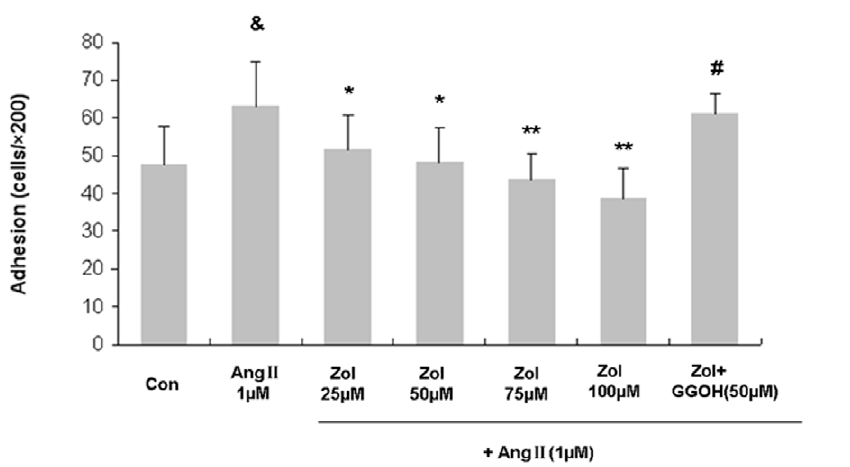
Figure 4. Adhesion capacity of EPCs treated with Ang II and Zol. Ang II increased EPC adhesion capacity, while Zol dose dependently decreased cell adhesion and GGOH showed reversal effect. Data are presented as mean 6 SD, n=5. &P , 0.05 vs. control group; * P , 0.05 vs. Ang II